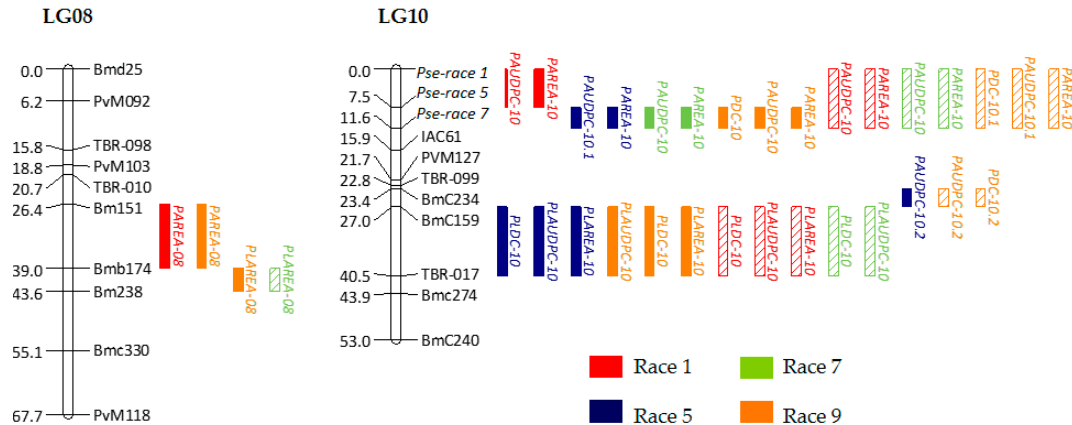
Figure 3. The position of the identified QTLs on the LGs 08 and 10 in the common bean consensus map from F 2 UI3T and UI3A52 populations. Distance in cM between markers is shown to the left of the LGs. Names of the markers are shown to the right. QTLs are presented as vertical bars to the right of the LGs. Colors identifying Psp races are shown. Single-locus effect QTLs detected in populations UI3T and UI3A52 are shown in solid color and diagonal strip bars, respectively. Table 4. Distribution of molecular markers on the consensus linkage map constructed from individual UI3T and UI3A52 F 2 maps.